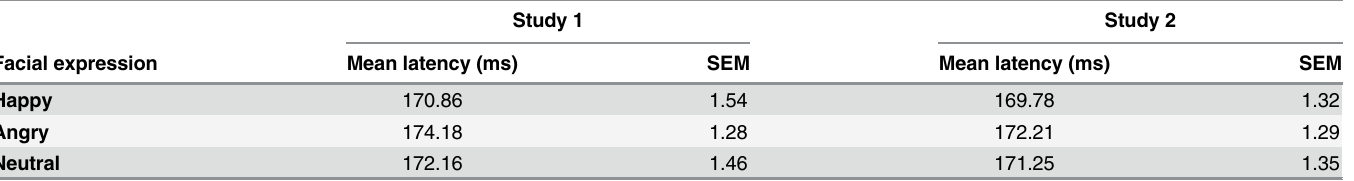
Study 1 Study 2